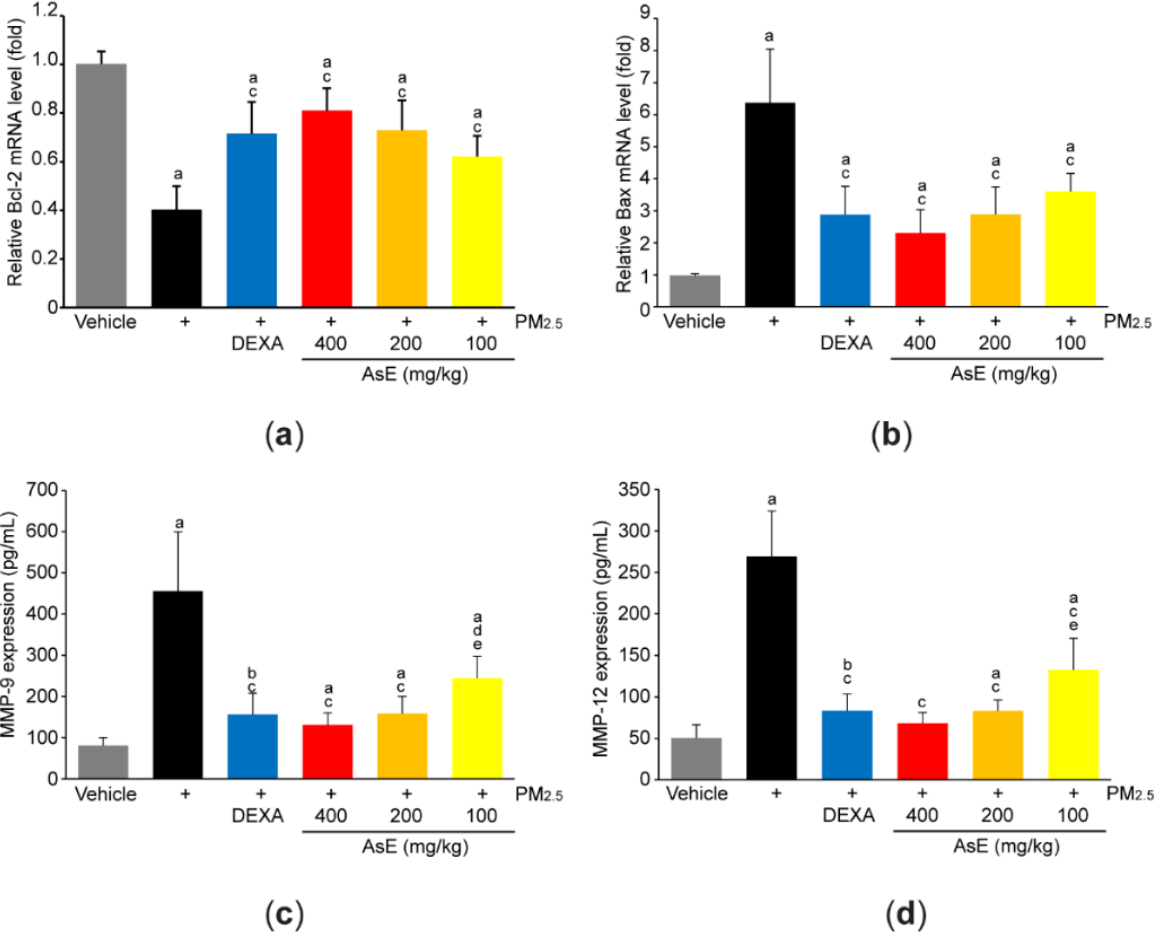
Figure 3. AsE blocks PM 2.5 -induced pulmonary damages. ( a , b ) qPCR analyses. Total RNAs isolated from the left lobes were used to quantify expression level of Bcl-2 ( a ) and Bax ( b ). ( c , d ) ELISA analyses. Protein homogenate obtained from the lower right lobes were used to quantify expression level of MMP-9 ( c ) and MMP-12 ( d ). a p < 0.01, b p < 0.05 versus vehicle group; c p < 0.01, d p < 0.05 versus PM 2.5 group; e p < 0.05 versus PM 2.5 + DEXA group; Bcl-2, B-cell lymphoma 2; Bax, Bcl-2 asso- ciated X; ELISA, enzyme-linked immunosorbent assay; MMP, matrix metalloproteinase; qPCR, quantitative polymerase chain reaction.